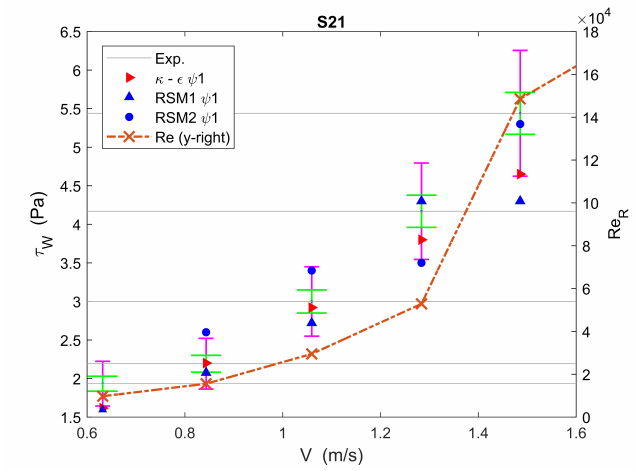
Figure 11. τ y = 0.43 Pa, m = 0.0831 Pas n , n = 0.5207 and D = 100